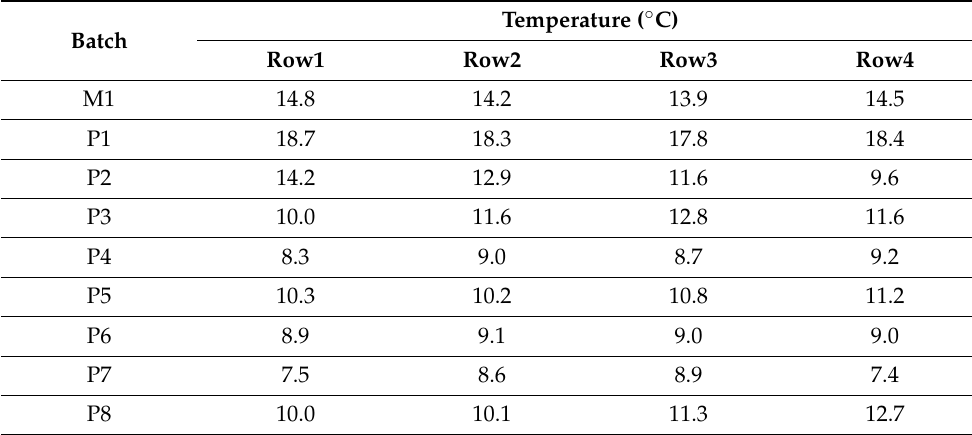
Table 2. Temperature measurement